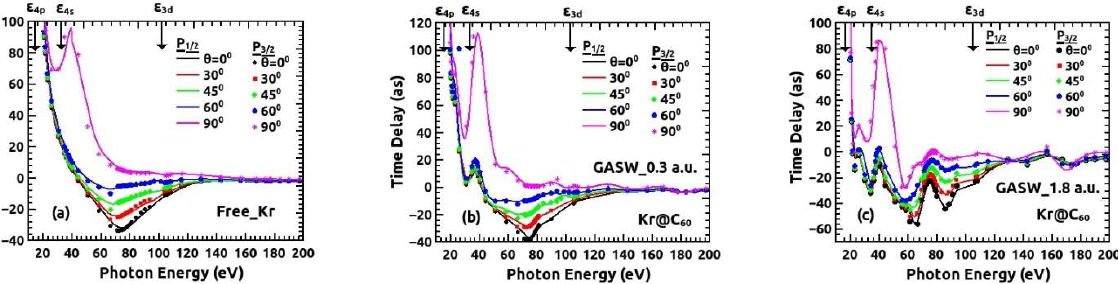
Figure 10. Spin average, angle-dependent time delay of photoionization from the 4p 1/2 and 4p 3/2 subshells of ( a ) free ( left panel ) and confined Kr with the depth of ( b ) 0.3 a.u. ( middle panel ), and ( c ) 1.8 a.u. ( right panel ). Vertical arrows indicate the threshold values of the corresponding subshells used in the RRPA.